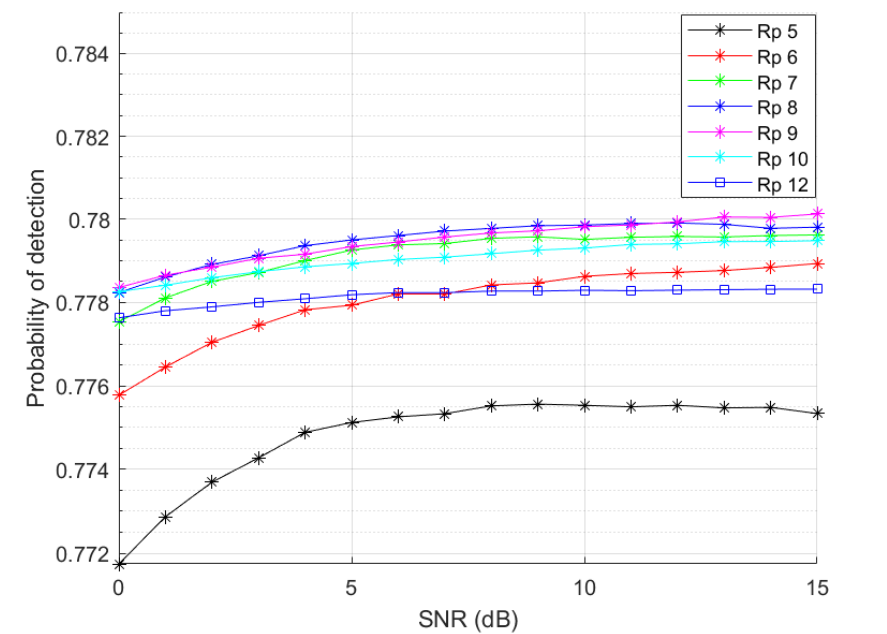
Figure 19. Accuracy in ROAD statistics-based detection vs. SNR.